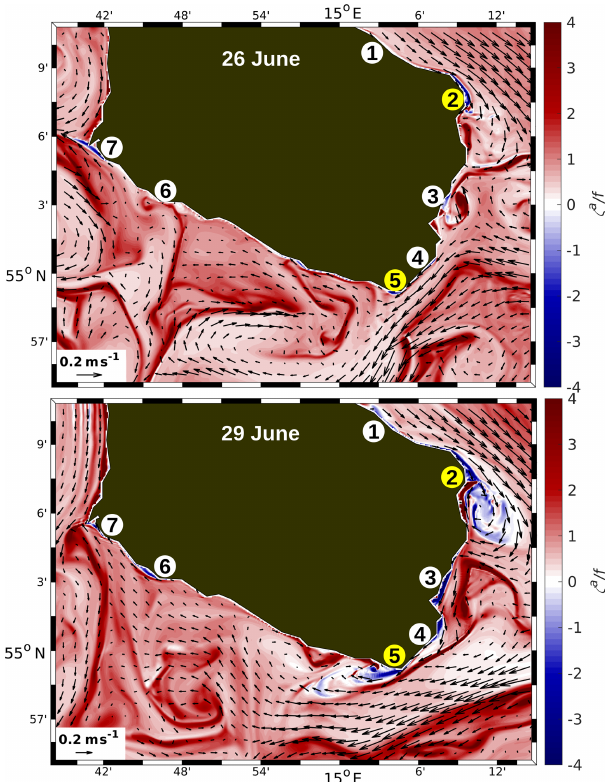
Figure 13. R100: normalized absolute vorticity, ζ a /f , in the surface layer of the waters around Bornholm on 26 and 29 June. Encircled numbers indicate near-coastal locations of ζ a /f < 0. Yellow circles mark locations where inertial instabilities tend to grow